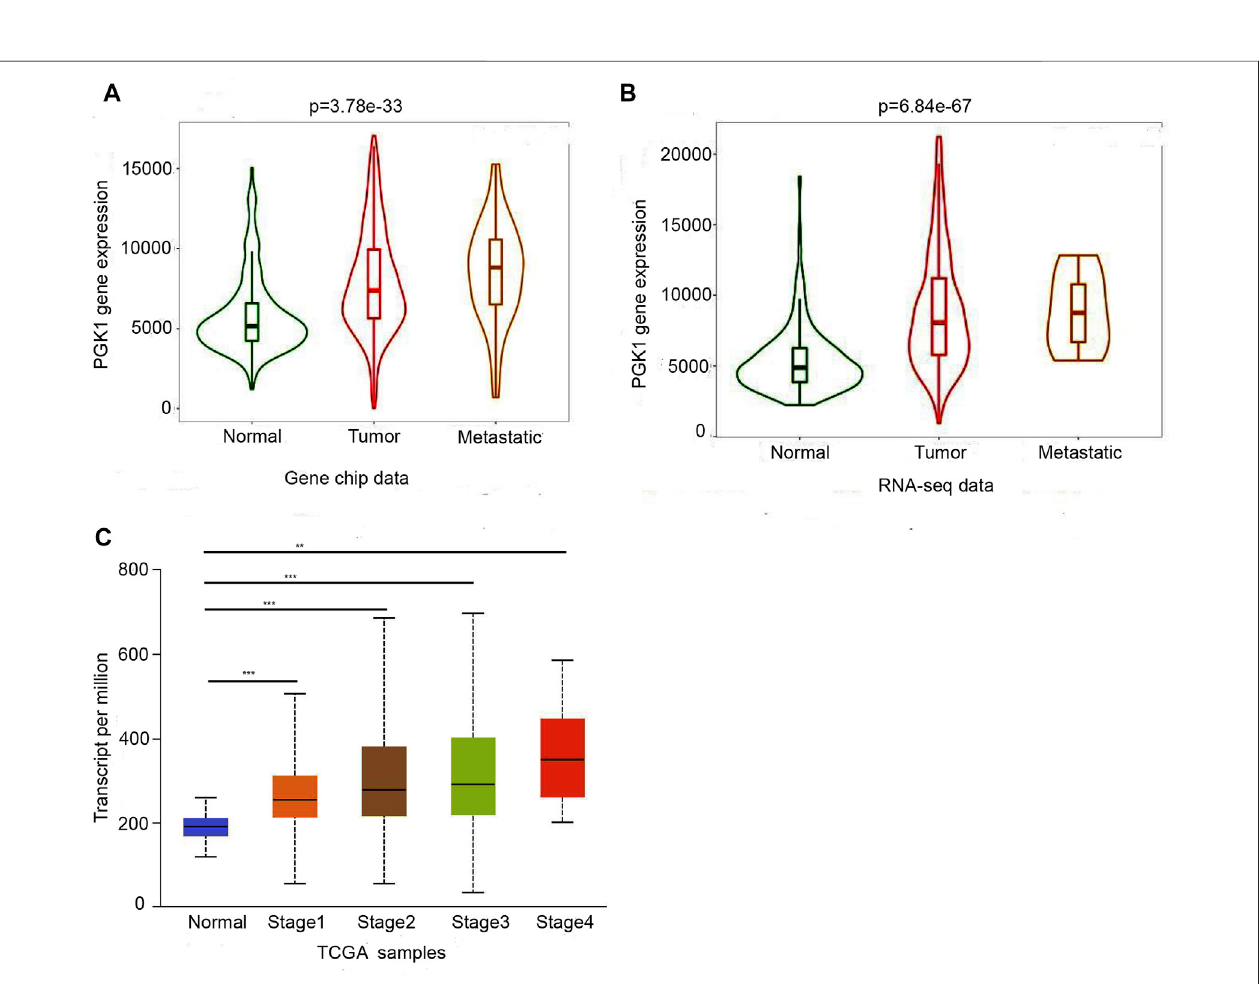
FIGURE 3 | Two boxplot graphs (A,B) of PGK1 gene expression in breast cancer by comparing paired normal, tumor, and metastatic tissues from gene chip data and RNA-seq data at TNMplot.com. Validation of differential expression using equally sized training and test sets con fi rmed the reliability of the database in breast cancer at an FDR below 10%. (C) Relationship between PGK1 expression and tumor stage in breast cancer patients. Boxplots displayed the PGK1 expression between normal and breast cance patients with stage 1, 2, 3, and 4, * means p < 0.05; ** means p < 0.01; ***means p < 0.001.